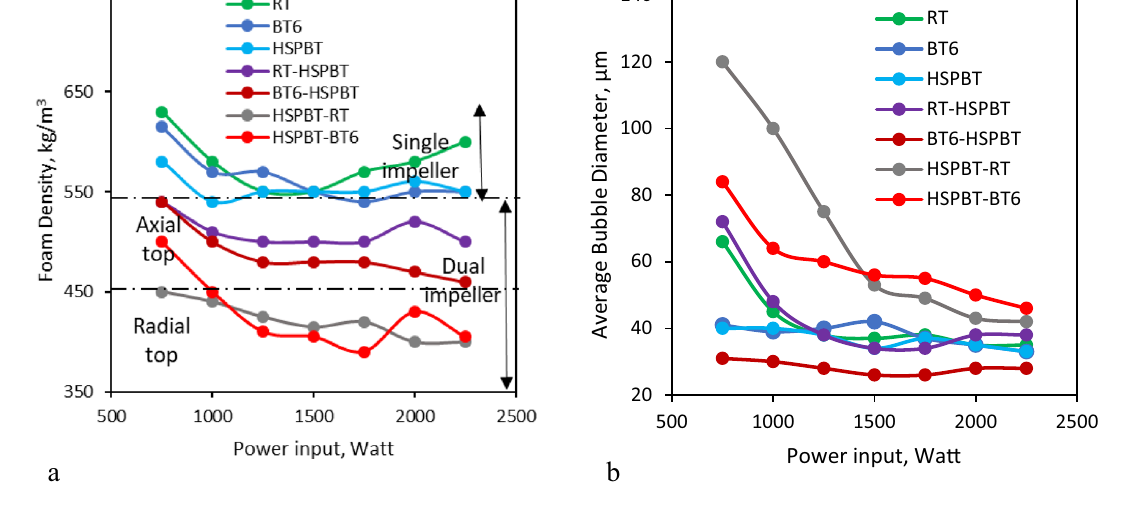
Fig. 5 a Foam density and b bubble size for aqueous